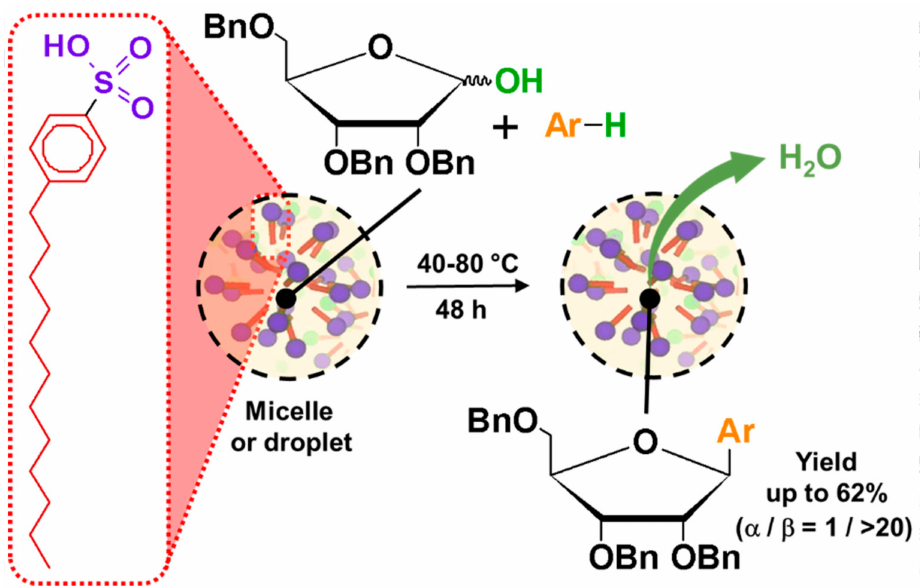
Figure 23. C-Glycosylations of 1-hydroxy sugar in water catalyzed by a Brønsted acid − surfactant, p -dodecylbenzenesulfonic